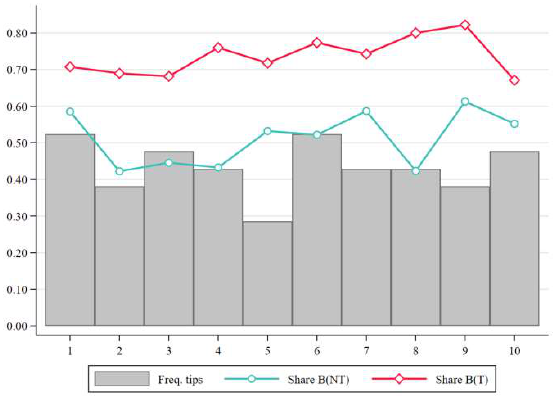
Figure 6. Frequency of tipping and Share for B.